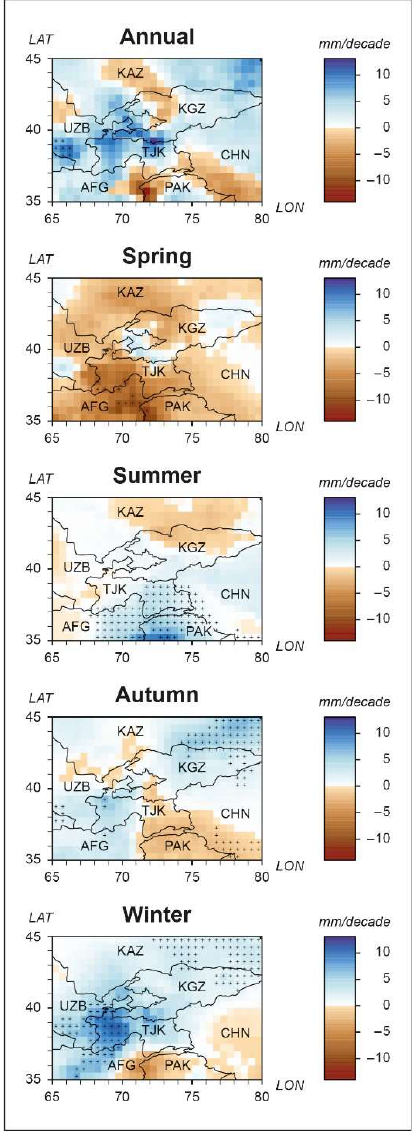
Figure 8. Seasonal and annual precipitation trends across the research area for 1950–2016.